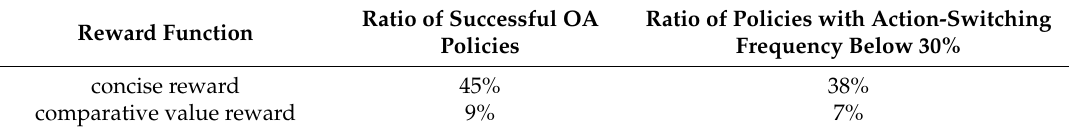
Table 6. Comparison of concise reward and comparative value reward.